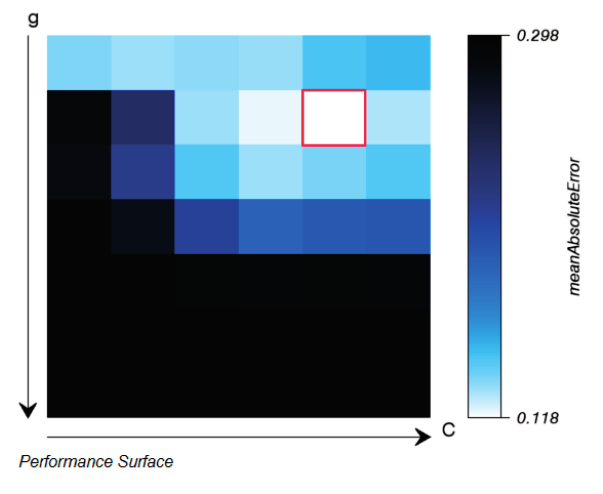
Figure 4. imageSVM regression: after completed parameter search the results from the grid search with internal cross-validation are displayed in an